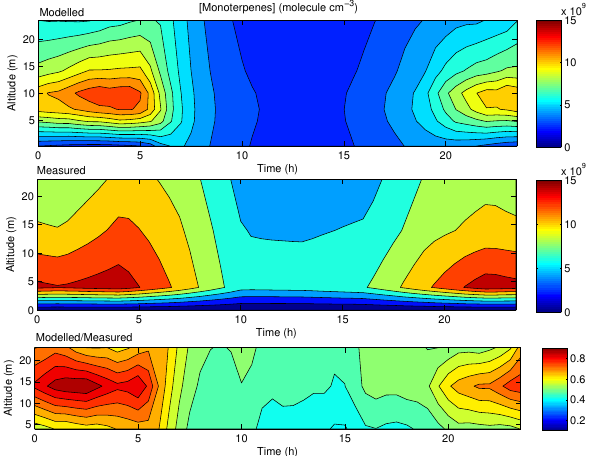
Figure 13. Modelled (MEGAN 2.04) and measured (at the SMEAR II station) monoterpene concentration vertical profiles for winter